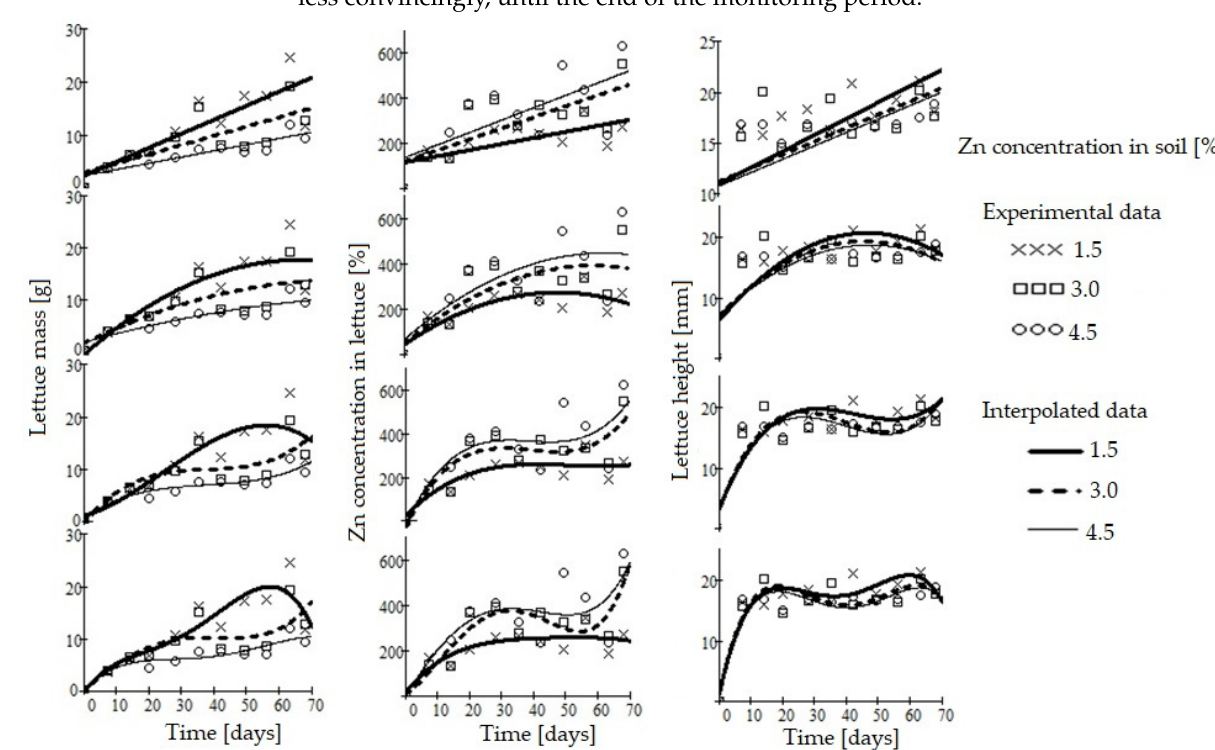
Figure 6. Graphical representation of Zn concentration, mass, and plant height over time, obtained by polynomial interpolation (1–4 degree ordered top to bottom of graph) and experimental data.